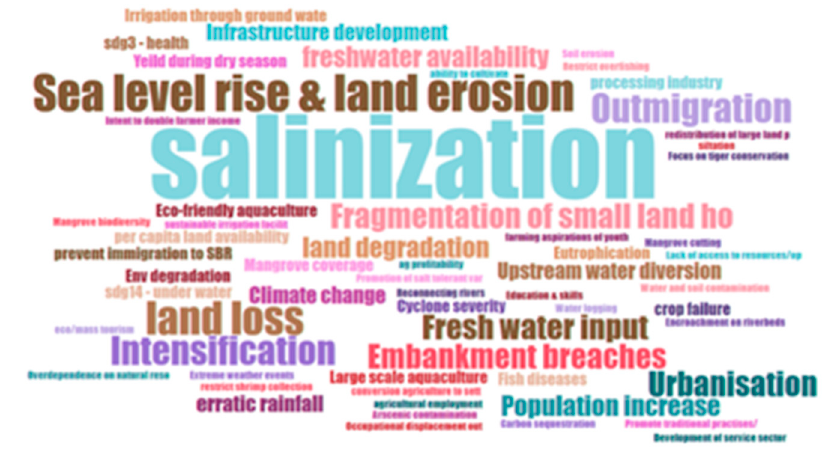
Figure 3. Word cloud of the frequency of mention of variables that were reported to influence another variable in workshop causal diagrams and expert interviews. “Land ho” refers to land hold- ings.